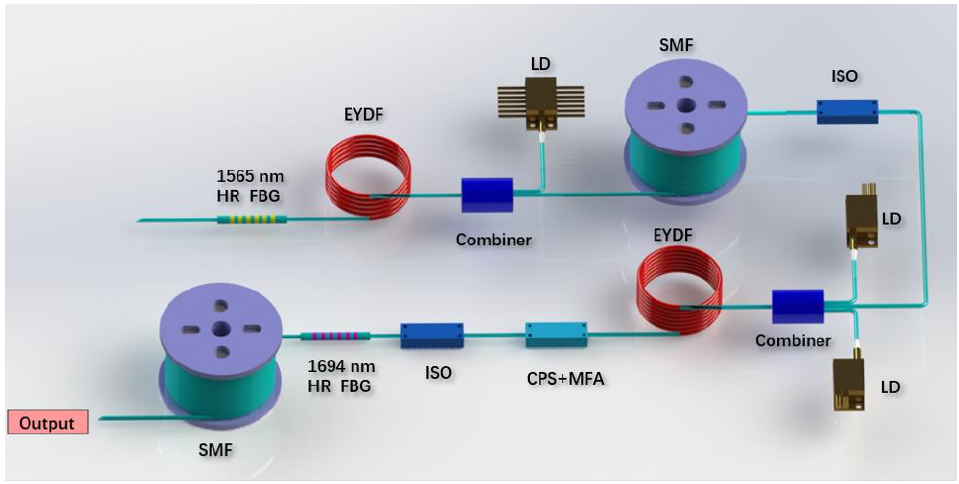
Figure 1. Schematic diagram of the experimental setup. HR FBG, high-reflectivity fiber Bragg grating. EYDF, erbium/ytterbium co-doped fiber. LD, laser diode. SMF, single-mode fiber. ISO, isolator. CPS + MFA, cladding power stripper and mode field